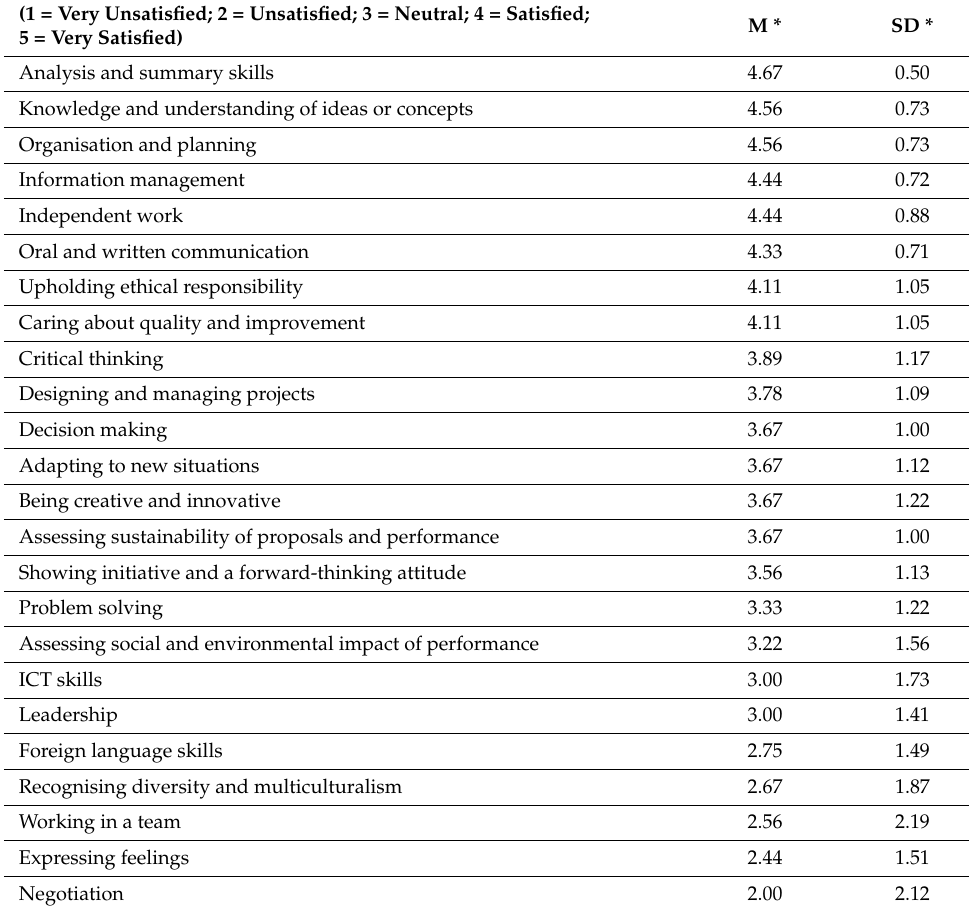
Table 4. Quantitative results: soft skills assessment, Level 2 (students).